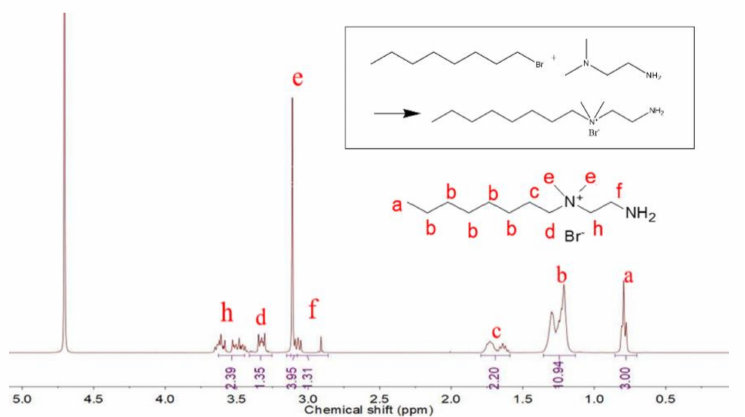
Figure 2. NMR spectrum of octyl-QDED.